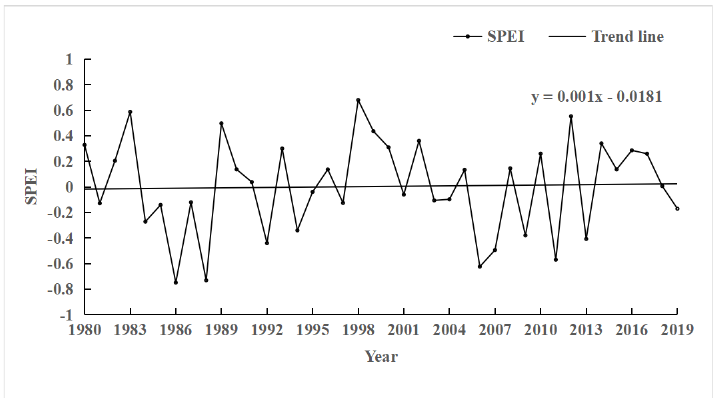
Figure 6. Changes in annual mean SPEI in the Yangtze River Basin from 1980 to